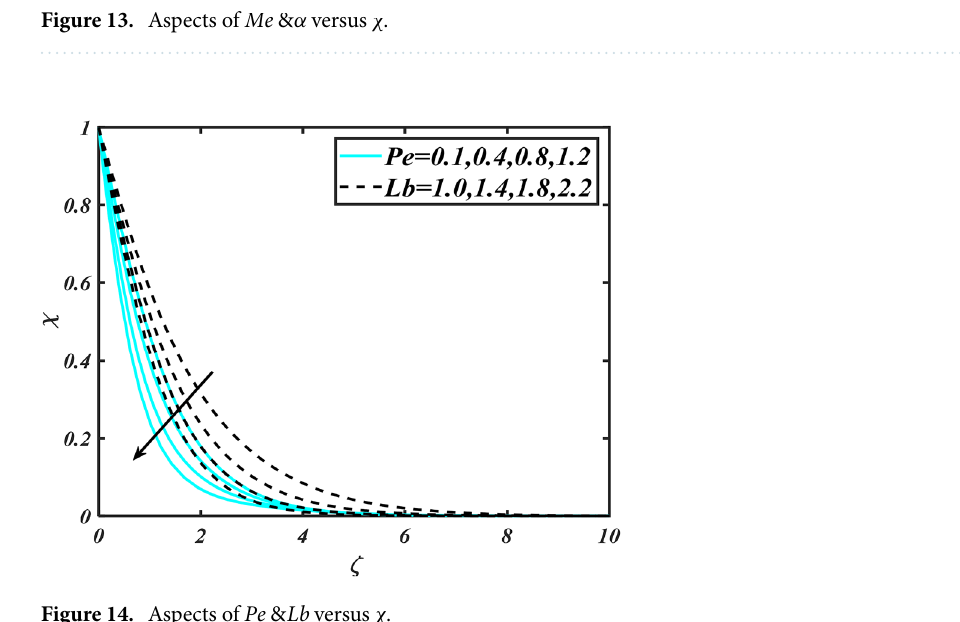
Figure 14. Aspects of Pe & Lb versus χ .